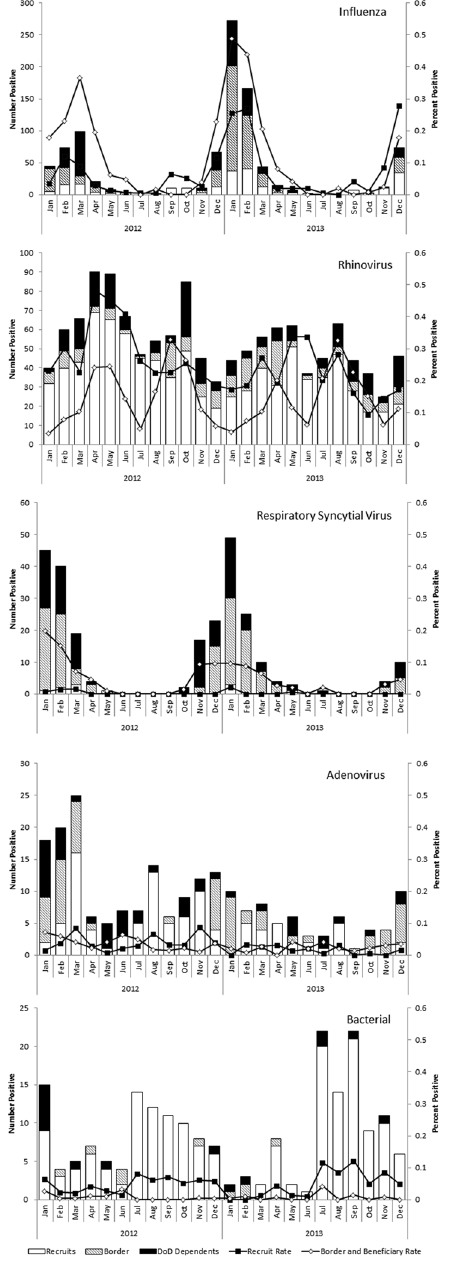
Fig. 1. Number positive and percent of febrile respiratory illness/severe acute respiratory infection (FRI/SARI) patients positive for respiratory pathogens among US military recruits, DoD beneficiaries, and US–Mexico border populations,